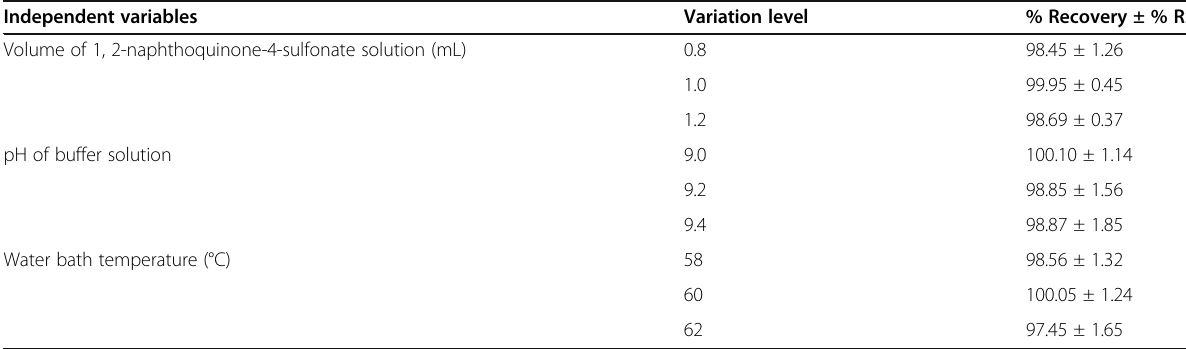
Table 1 Robustness investigation Independent variables Variation level